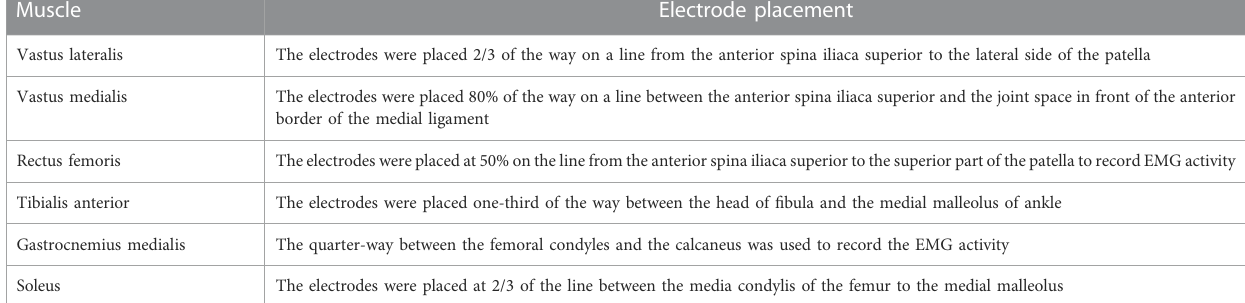
TABLE 1 Electrode placement. Muscle Electrode placement Vastus